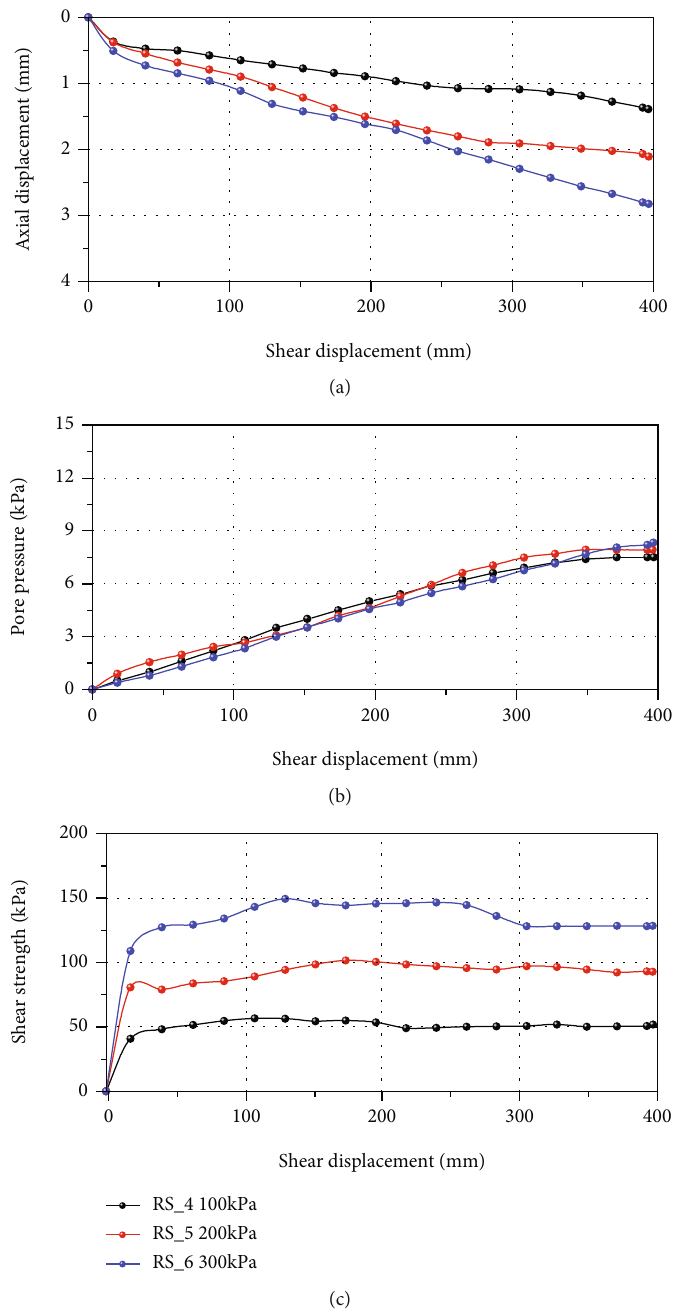
Figure 4: Results of ring shear tests with a shearing rate of